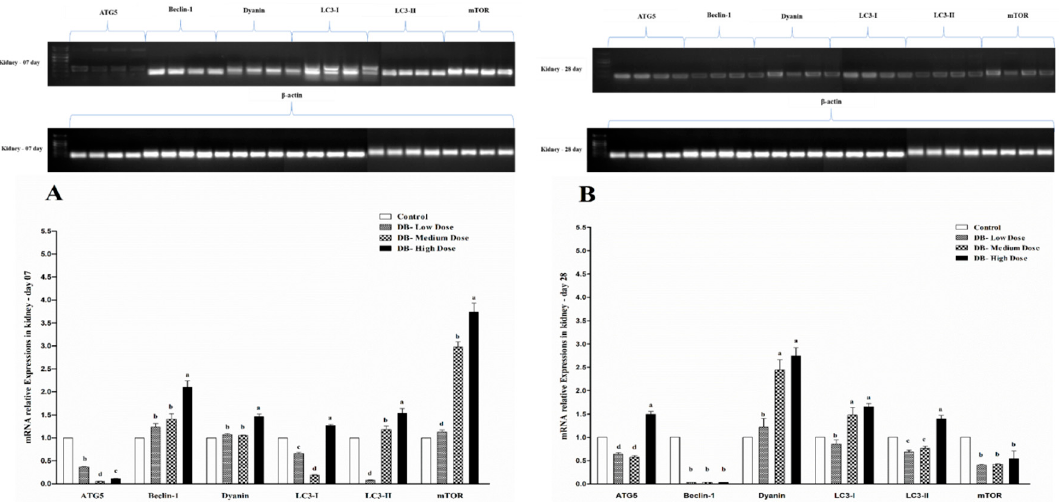
Figure 10. Effects of DB supplementation on kidney mRNA expressions of autophagy- related genes at 07 days ( A ) and 28 days ( B ) of age. Data are presented as mean value ± SEM (n = 6). Values without the same mark (a–d) represent statistically significant differences ( p < 0.05). ATG5; Beclin 1; Dynein; LC3-I; LC3-II, mTOR; Denatonium benzoate- Low Dose treated group, Denatonium benzoate- Medium Dose treated group, Denatonium benzoate- High dose treated group.